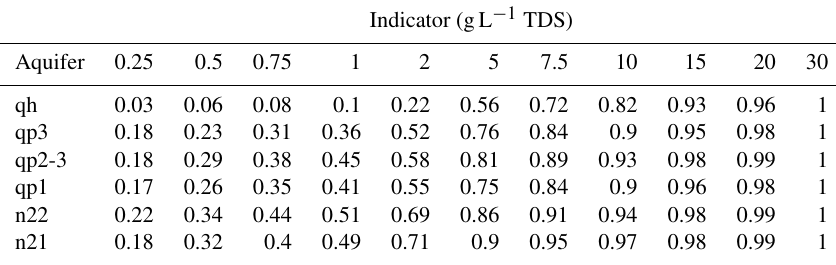
Figure 9. Statistical distributions of TDS for each aquifer. Table 2. Cumulative probabilities at indicator thresholds for each